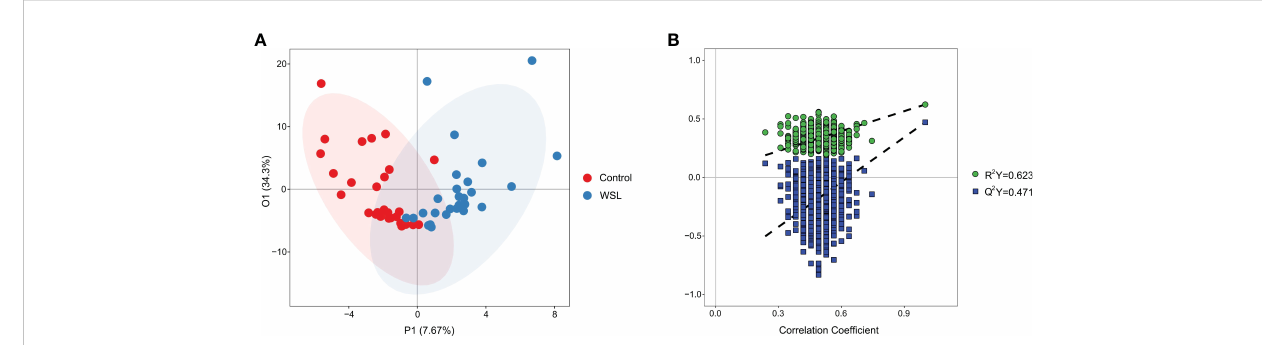
FIGURE 4 OPLS-DA. (A) Supervised OPLS-DA score plot of metabolite pro fi les in the control and WSL groups. The abscissa P1 indicates the predicted principal component score, and the ordinate O1 indicates the orthogonal principal component score. (B) Permutation test of the OPLS-DA model for the control and WSL groups. R 2 Y (cum) and Q 2 Y (cum) represent the interpretability and predictability of the models, respectively. Y-axis intercepts: R 2 Y=0.623, Q 2